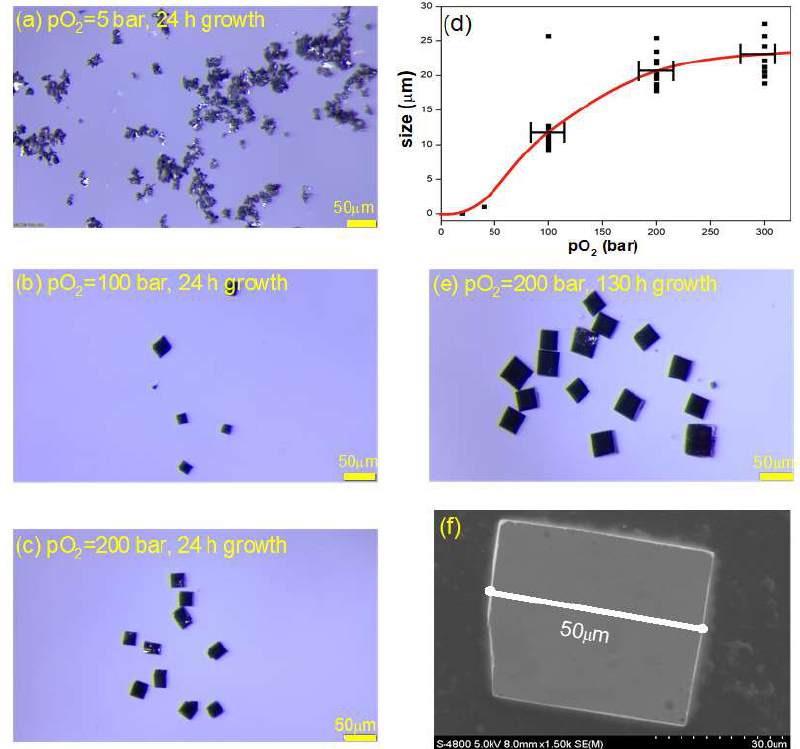
Figure 3. NdNiO 3 crystals grown under different pO 2 . ( a ) pO 2 = 5 bar, growth time 24 h; ( b ) pO 2 = 100 bar, growth time 24 h; ( c ) pO 2 = 200 bar, growth time 24 h. ( d ) The relationship between grain size and pO 2 under the same growth conditions (Error bars represent the oxygen pressure deviation, and the red curve is only a guide for the eye); ( e ) pO 2 = 200 bar, growth time 130 h; ( f ) SEM image of NdNiO 3 .